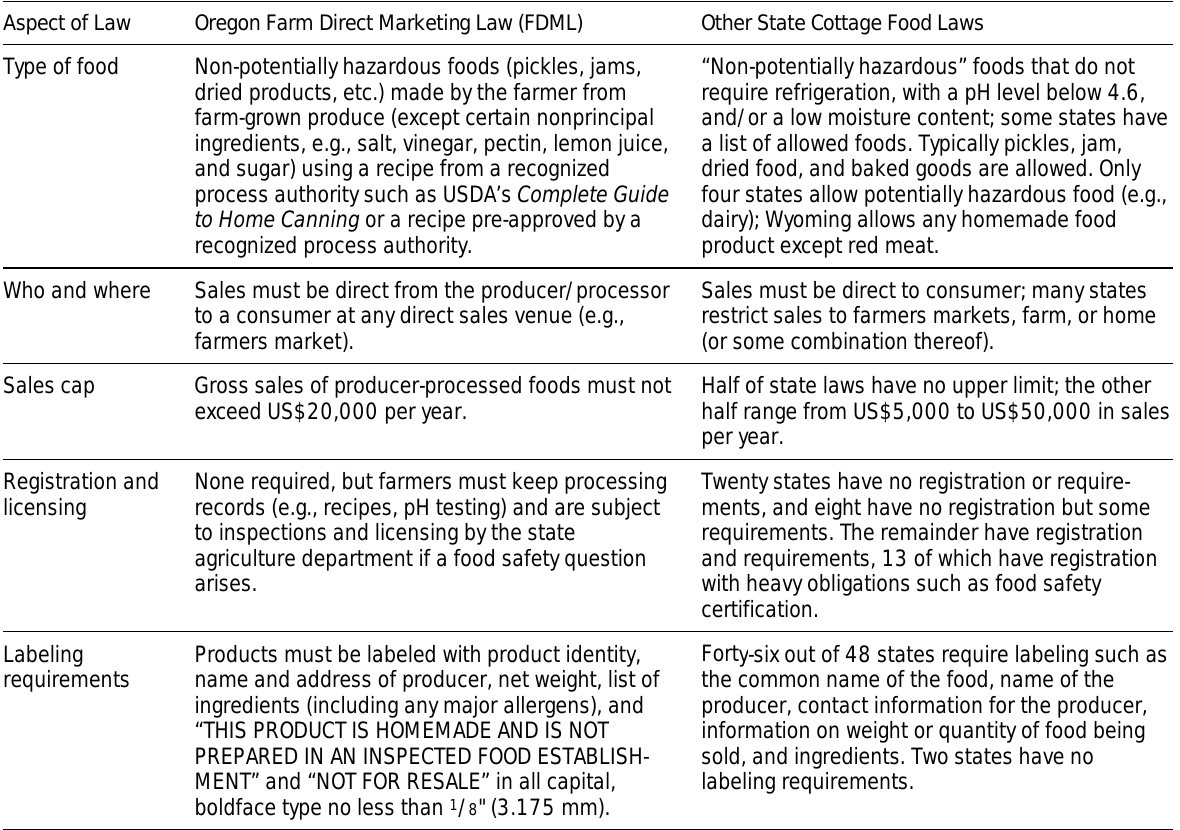
Table 1. Comparison of Oregon with Other State Cottage Food